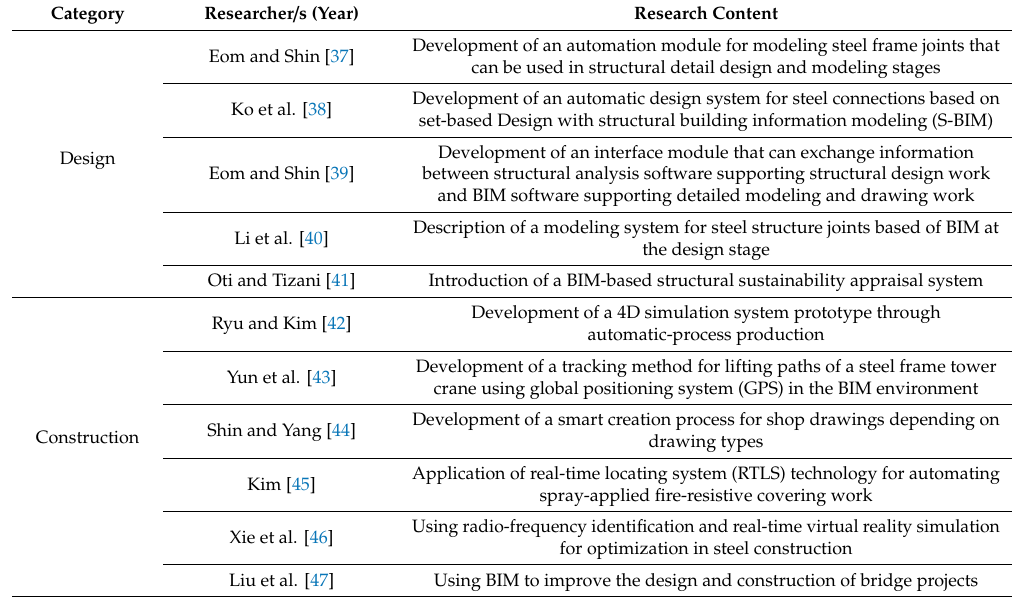
Table 2. Research highlights of previous studies that studied BIM for steel frame